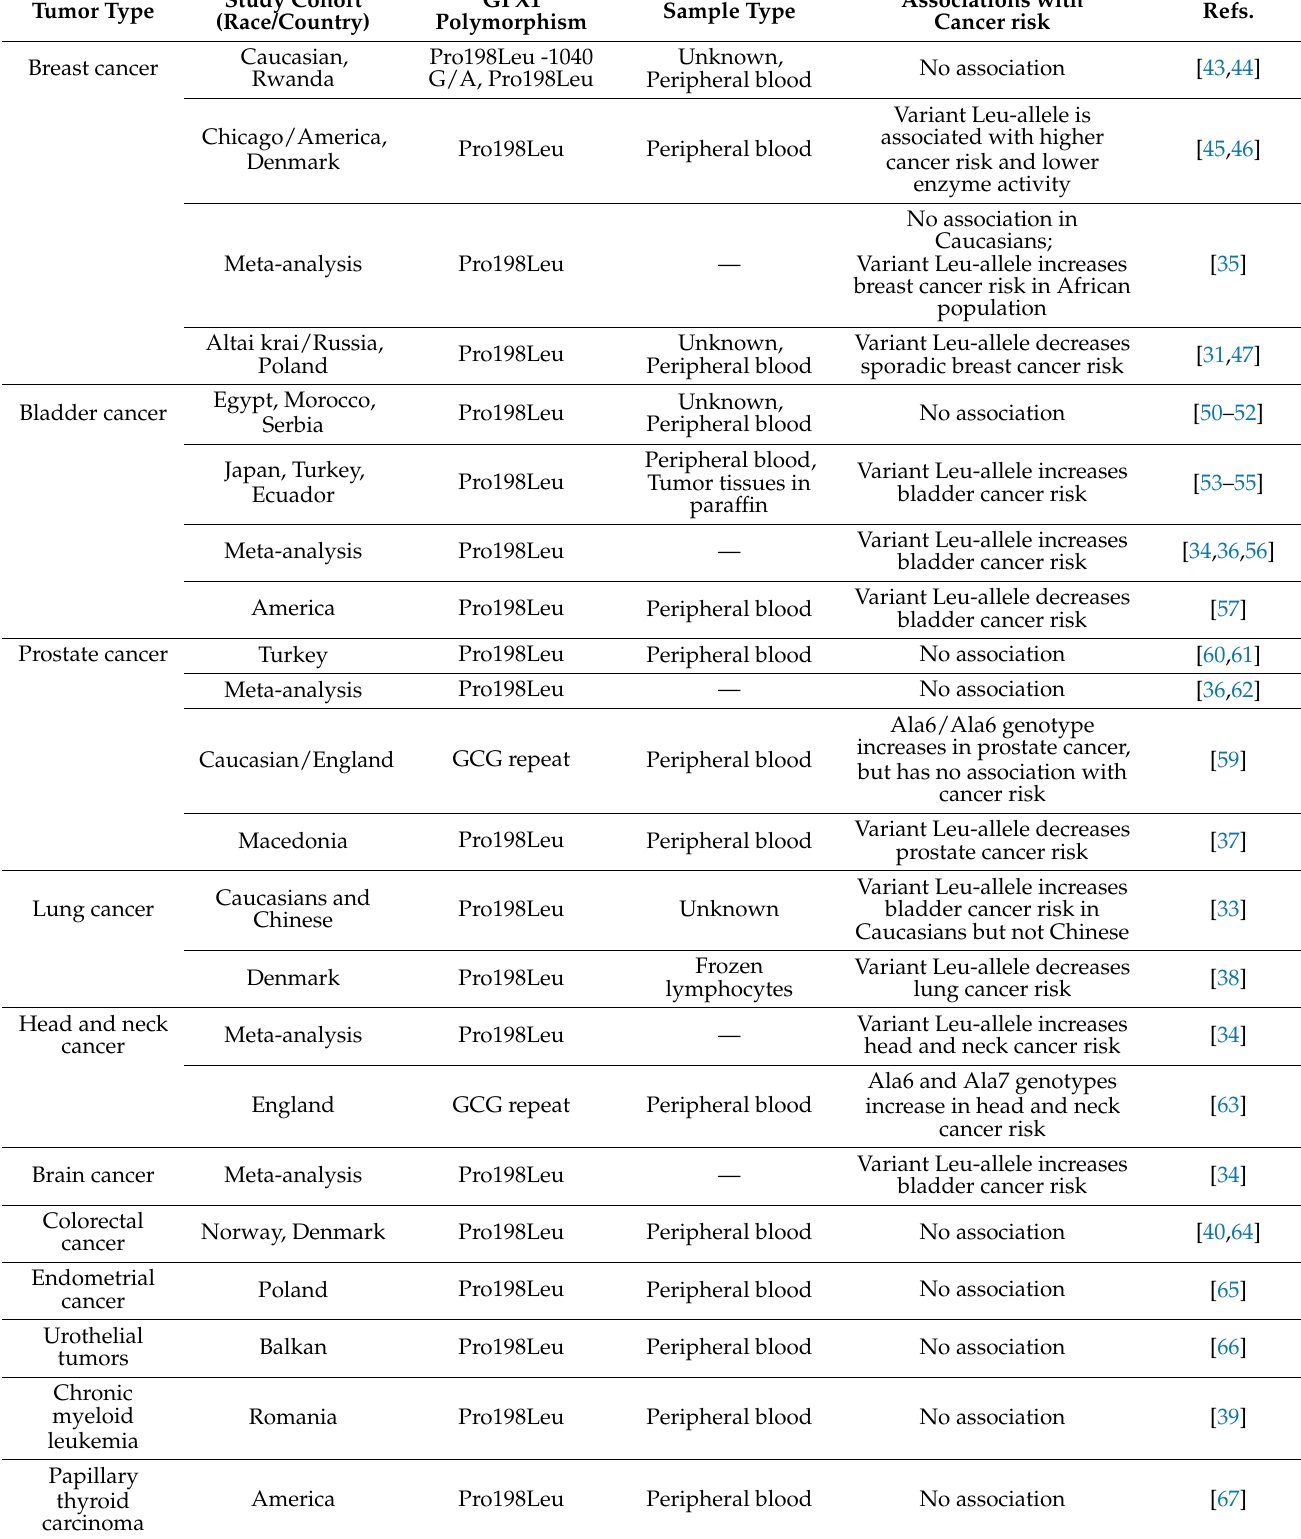
Table 1. The associations between GPX1 polymorphisms and cancer